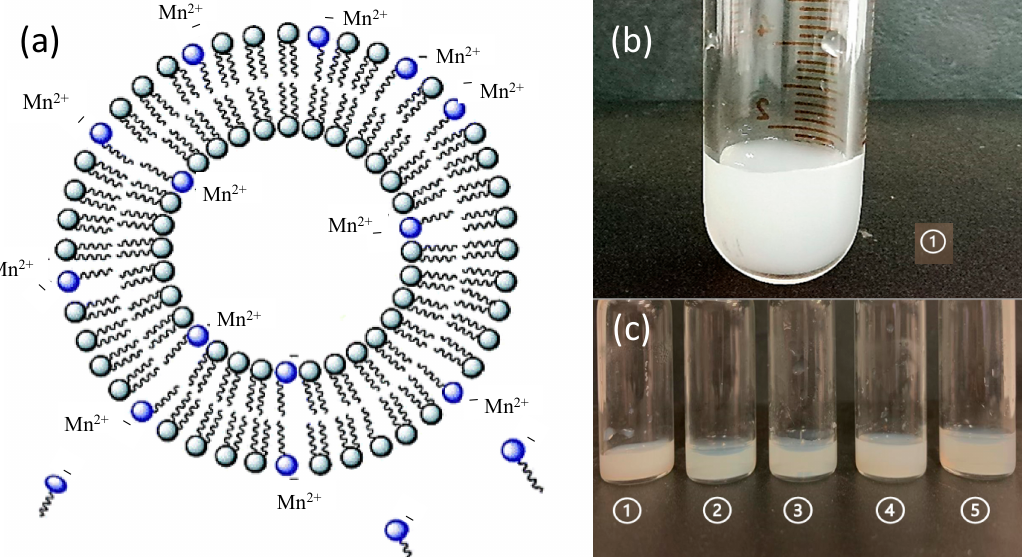
Figure 2. Schematic representation of the arrangement of surfactants in the phospholipid bilayer and of their possible electrostatic interaction with the manganese ion, namely Mn 2+ or Mn 3+ ( a ) and macroscopic aspect of the produced liposomal suspensions before ( b ) and after extrusion ( c ), 1: plain-LP; 2: LP-SD; 3: LP-NLS; 4: LP-PAG; 5: LP-SLL.